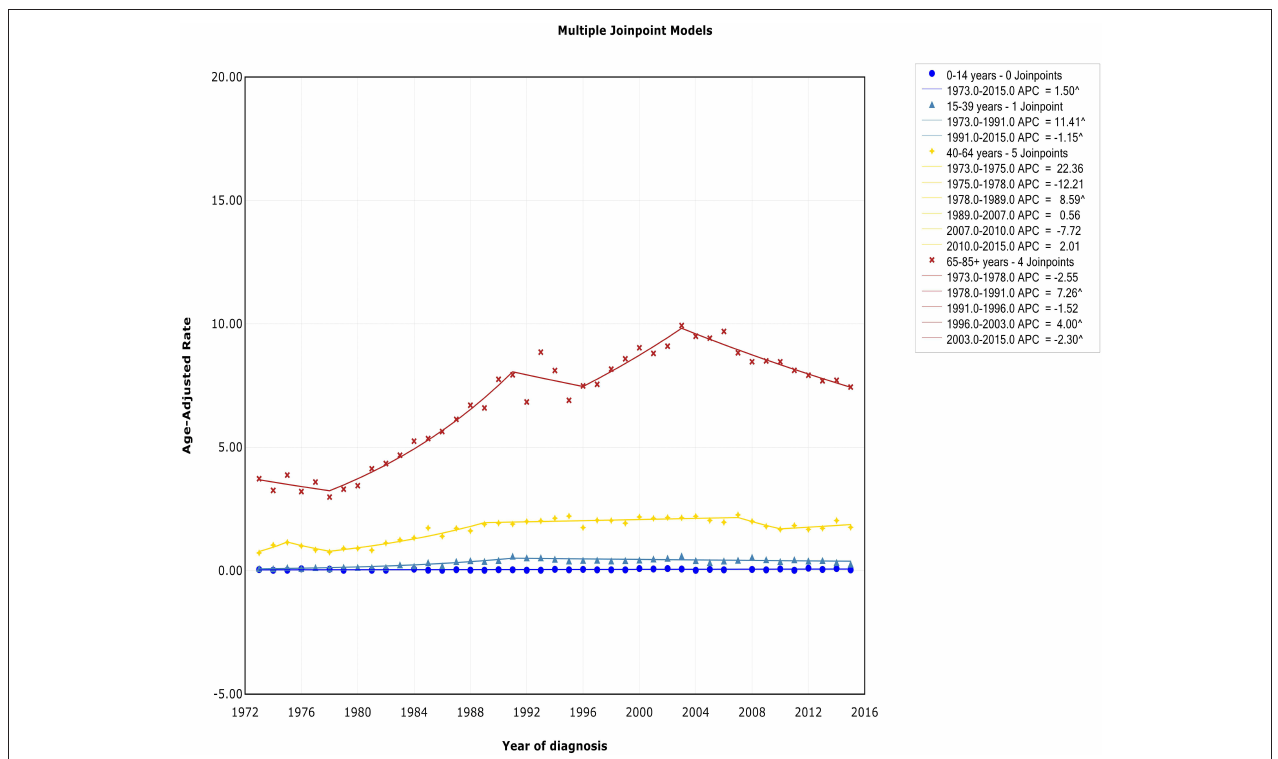
FIGURE 4 | Trends of annual incidence of extranodal DLBCL according to